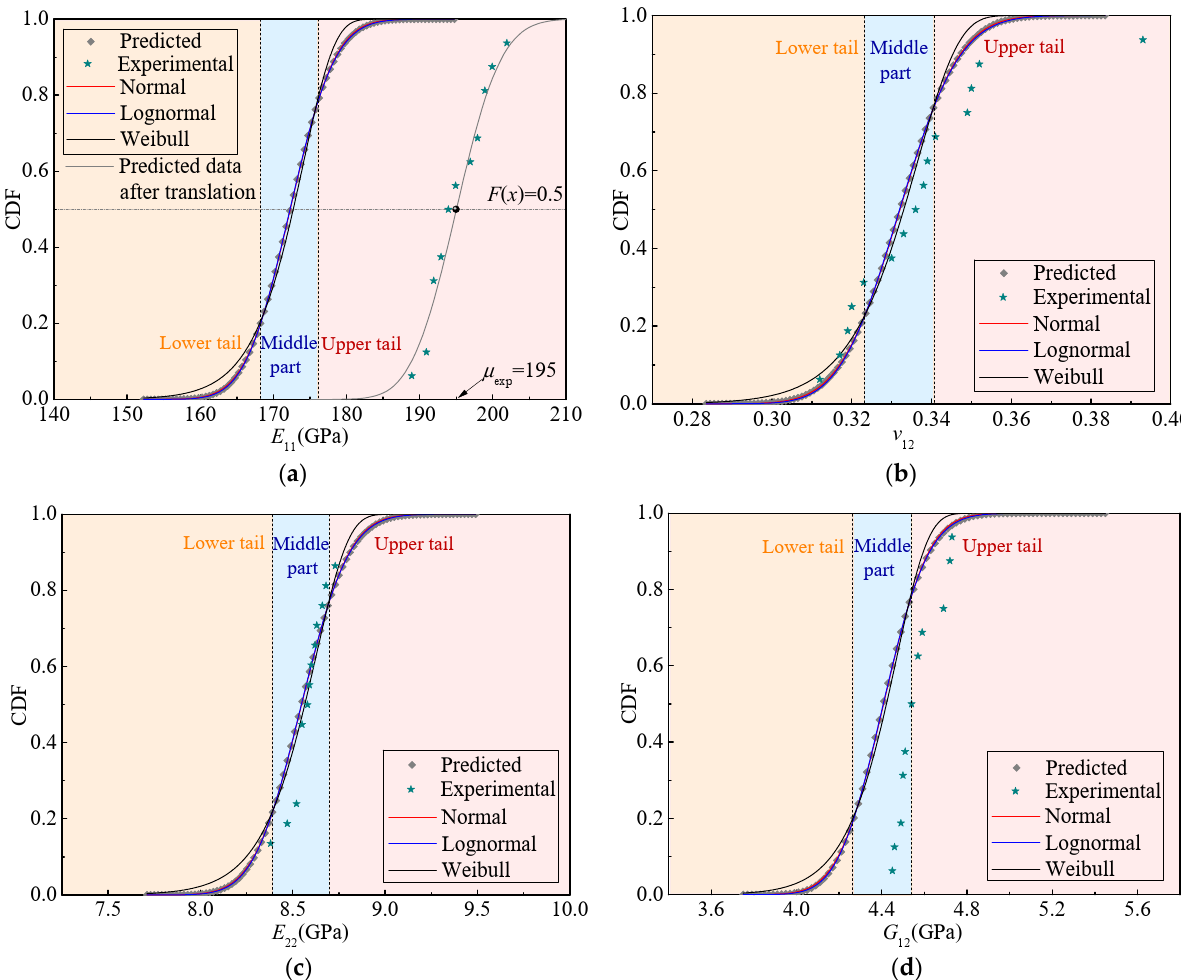
Figure 6. Cumulative distribution functions (CDFs) of the elastic properties of the T800/X850 composite. ( a ) E 11 ; ( b ) v 12 ; ( c ) E 22 ; ( d ) G 12 .